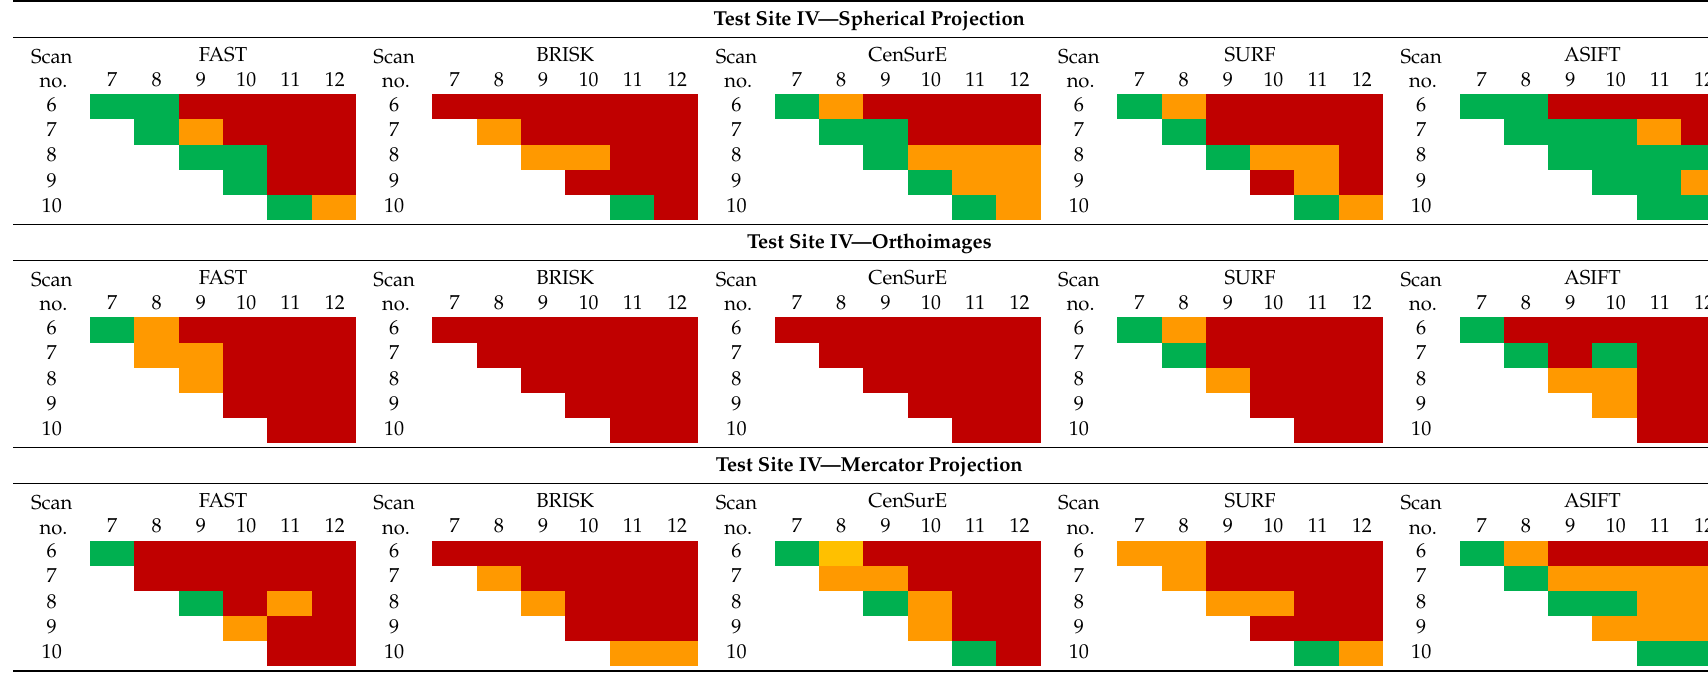
Table 5. The accuracy of the automated connecting of scans for Test Site IV (both scenarios): green, correct matching (full registration), orange, preliminary orientation requiring the final registration using the ICP method and red, no matching.